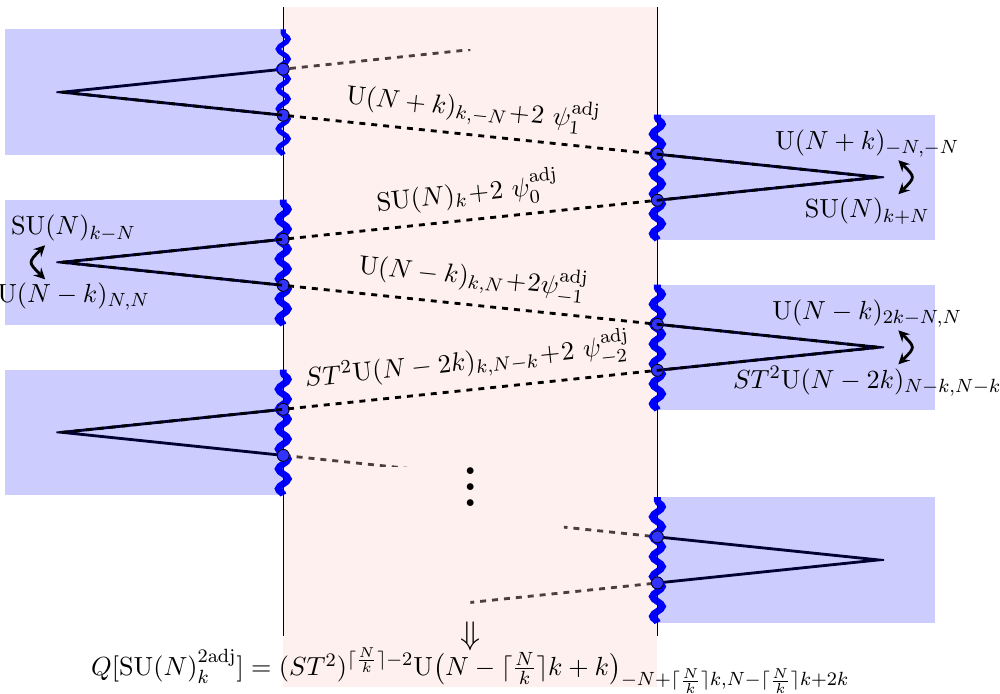
Figure 9 . The duality chain for the theory of SU( N ) k + 2 adj